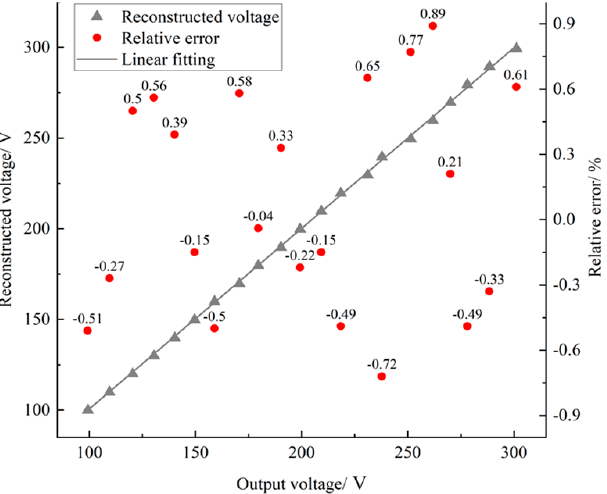
As can be seen from Figure 7, in the test of amplitude accuracy test, the maximum error between the reconstructed voltage and the actual output voltage is –0.89%. The calculation of reconstruction voltage is shown in Equation (10), and the calculation of relative error is shown in Equation (14).